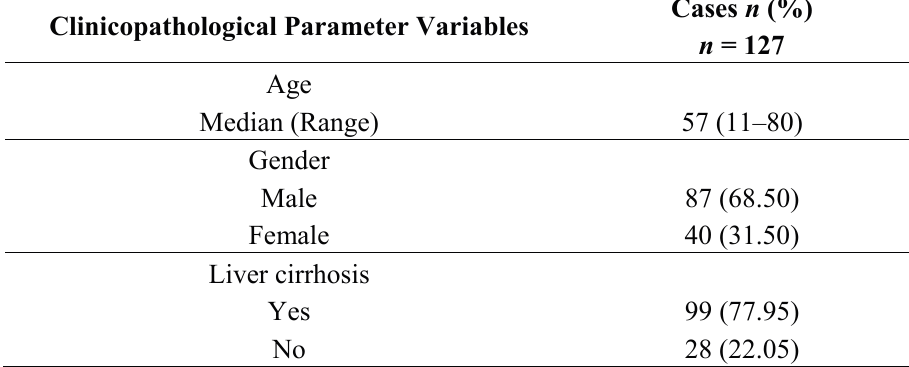
Table 2. Clinicopathological parameters of 127 patients with